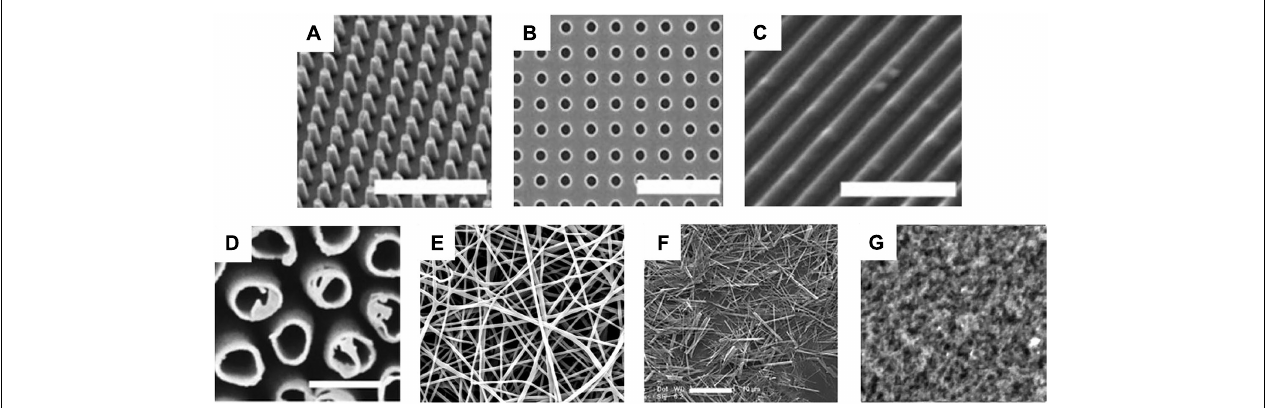
FIGURE 2 | Different types of topographies used to mimic the extracellular matrix of tissues: (A) pillars, (B) pits, (C) grooves/gratings, (D) tubes, (E) fibers, (F) wires, and (G) roughness (Dobbenga et al., 2016).